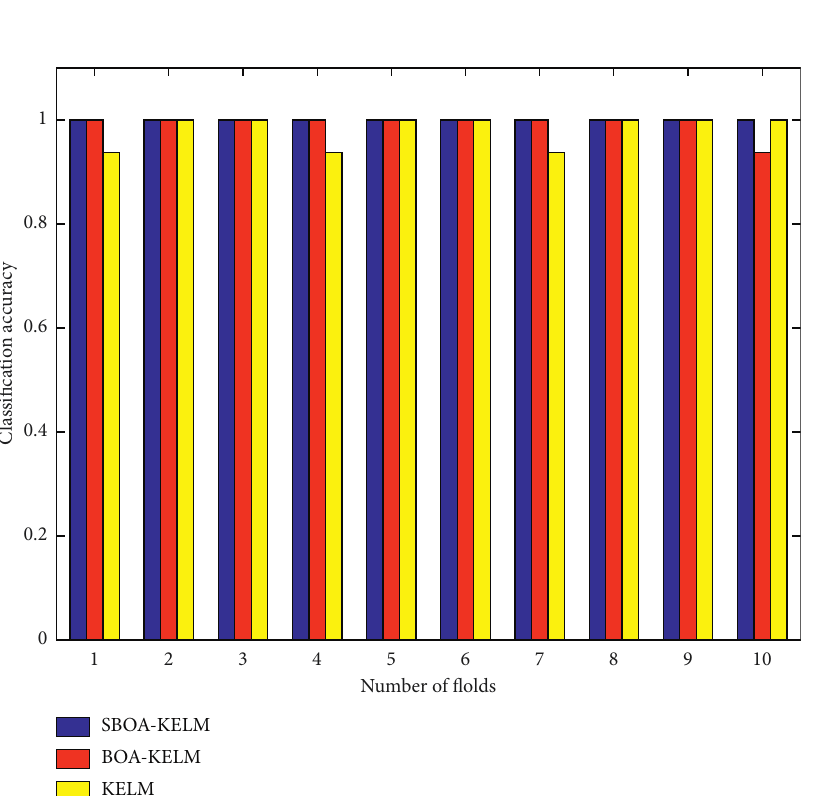
Figure 6: Performance comparison of SBOA-KELM, BOA-KELM, and ELM via the 10-fold CV